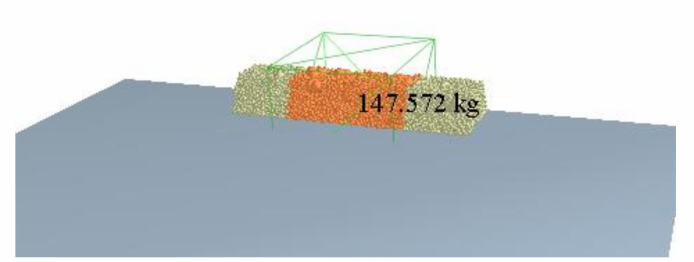
Figure 12. Initial soil ridge